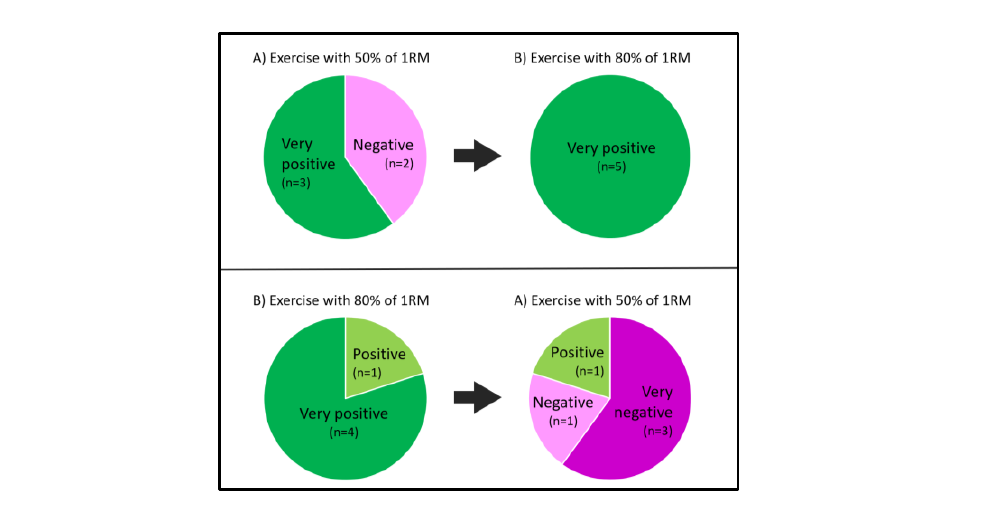
Figure 3. Scatter plot of lactate levels and participants’ experiences after the resistance exercise sessions.